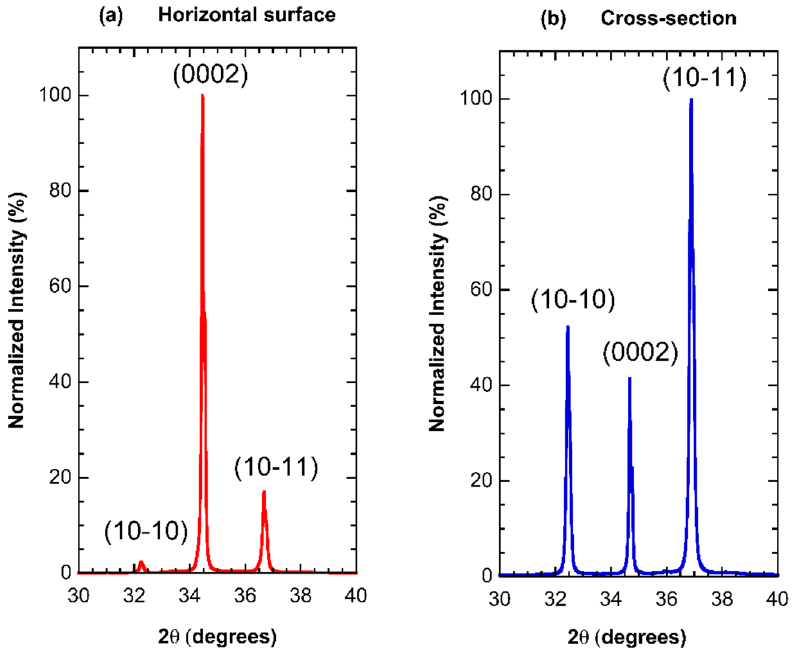
Figure 2. XRD patterns of the pure Mg sample forged at room temperature; ( a ) horizontal surface of the sample, ( b ) vertical